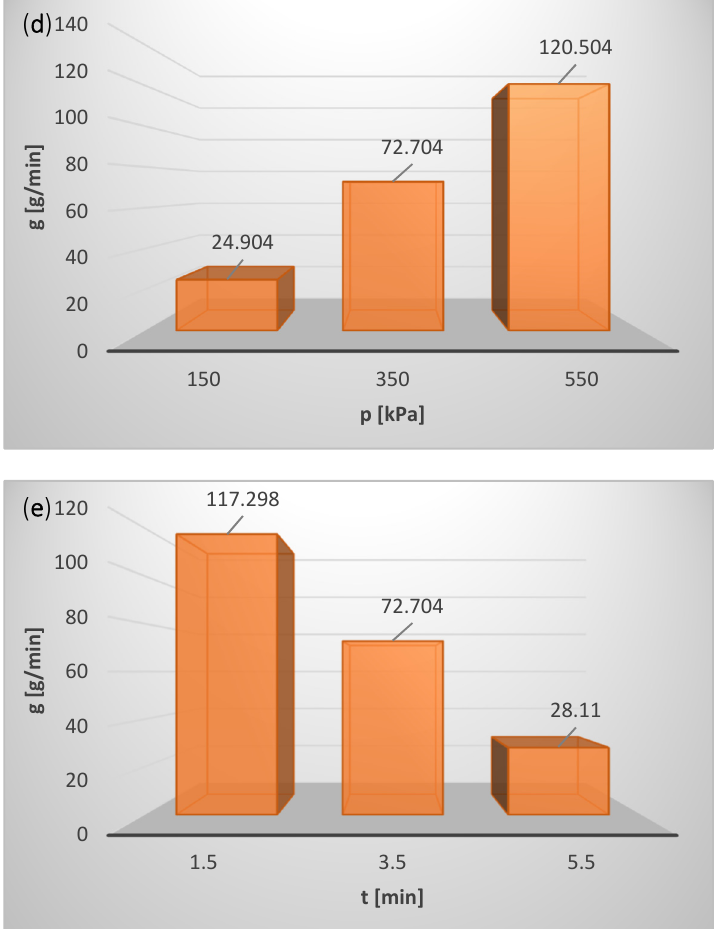
Figure 6. Influence of operating parameters on performance of classification process for ( a ) mass of fed material, m f , ( b ) Sauter mean diameter of fed material, d af , ( c ) classifier rotor speed, n, ( d ) working air pressure, p, ( e ) test conducting time, t. The effects of the input variables on Sauter mean diameter d ap of the product and cut size X are depicted in Figure 7.